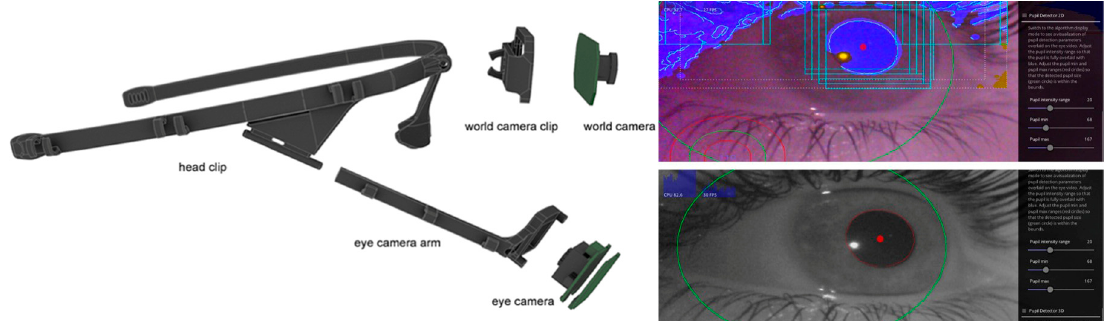
Figure 3. Pupil Pupil Head Set and